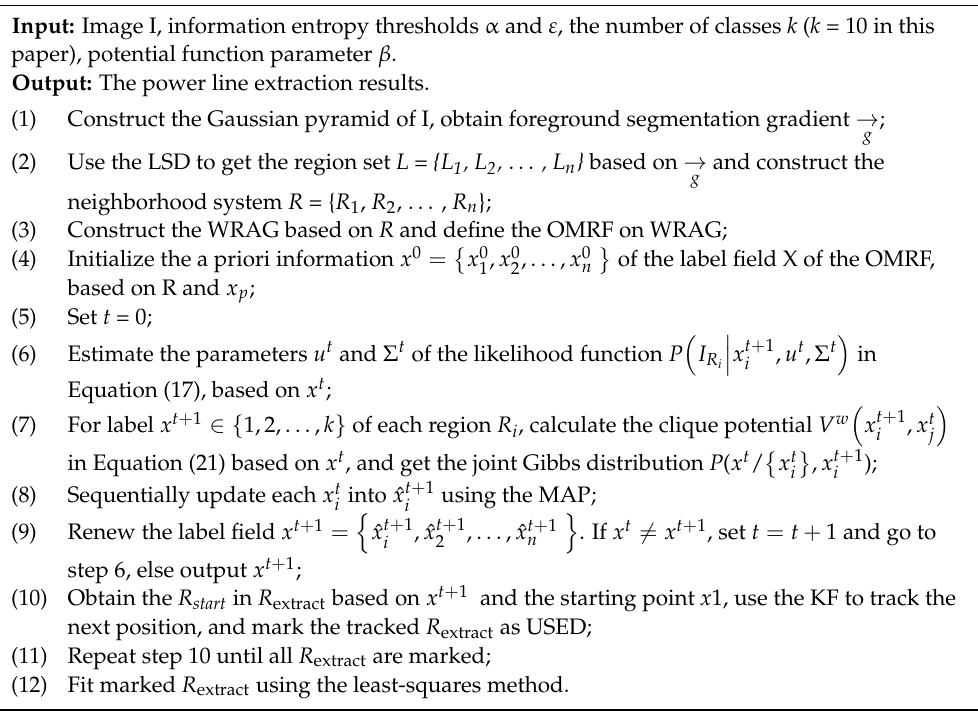
Algorithm 1: Power line extraction algorithm based on multi-scale LSD and